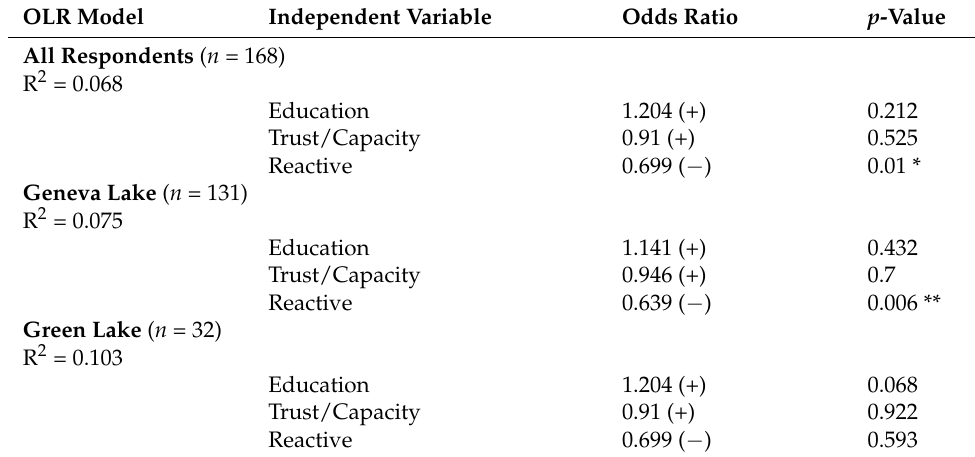
Table 5. Ordered logistic regression results.